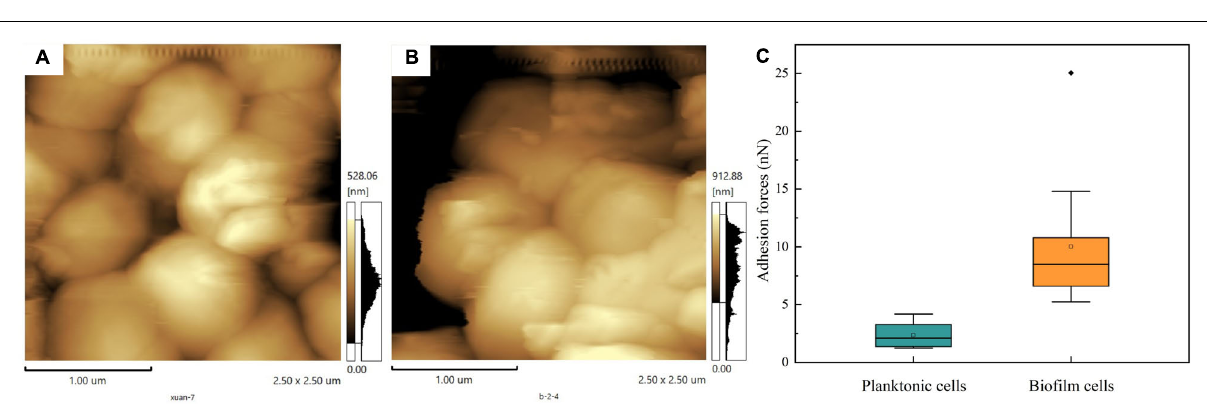
FIGURE 6 | Cell surface adhesion forces. (A) AFM images of planktonic cells. (B) AFM images of biofilm. (C) Adhesion force on the surface of planktonic cells and